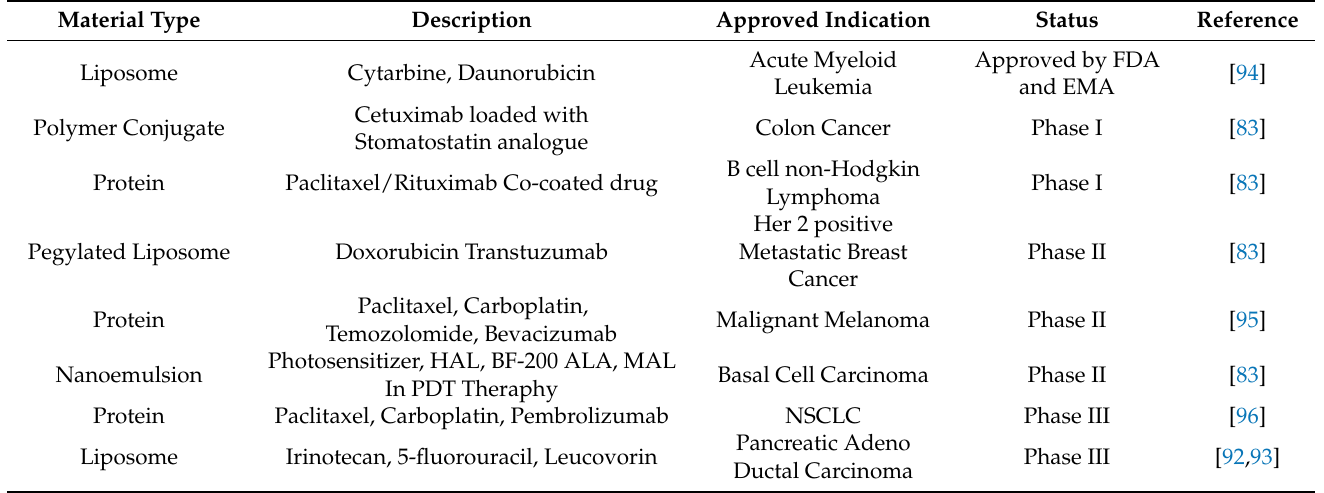
Table 1. Clinical trials using nanomedicine for combination